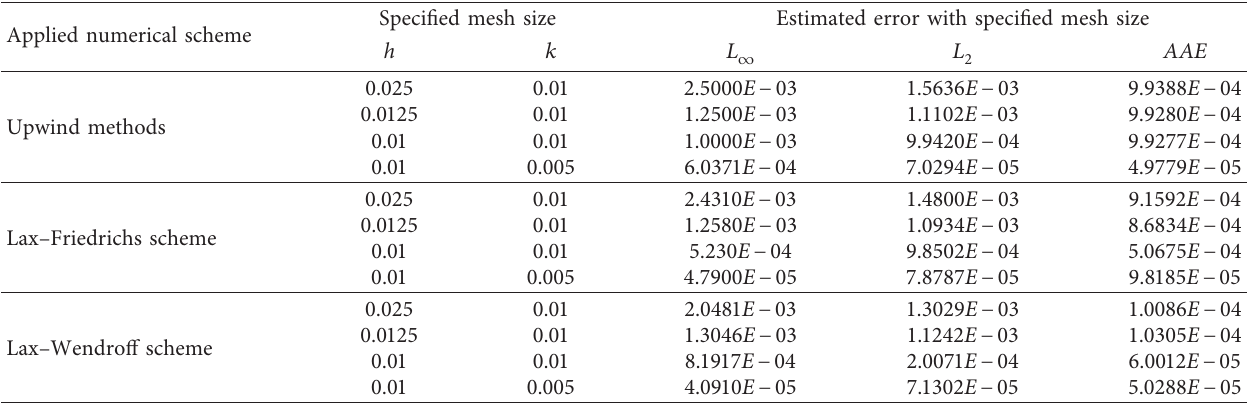
Table 2: Comparison of point average absolute error, root mean square error, and pointwise maximum absolute error for problem give in